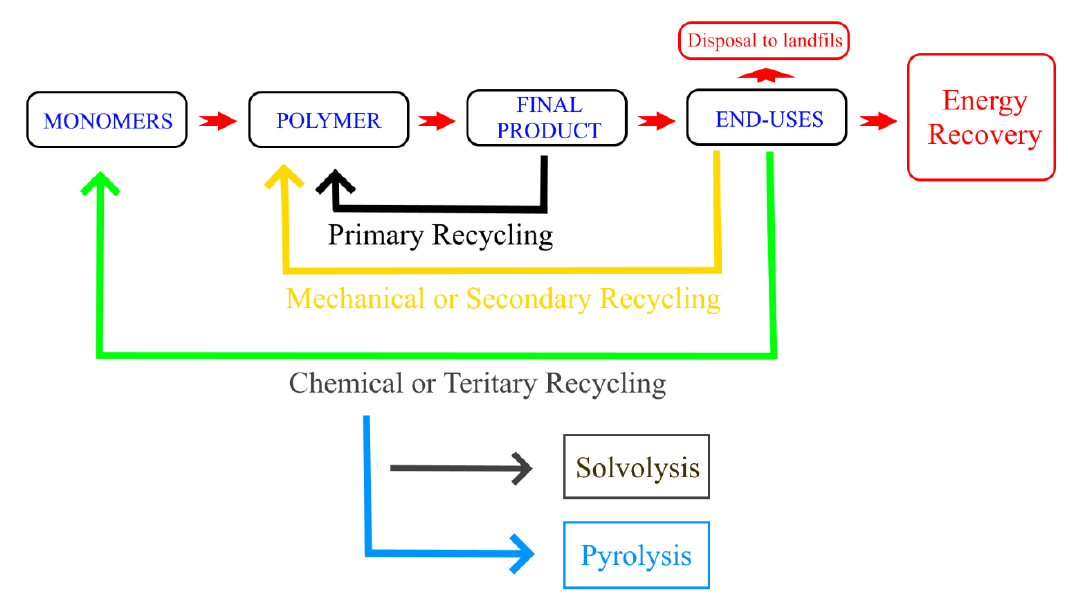
Figure 3. Schematic representation of the recycling methods.